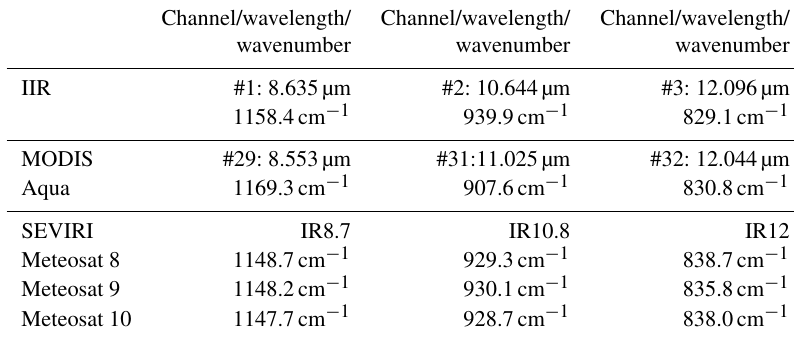
Table 2. Equivalent central wavelengths and wavenumbers.